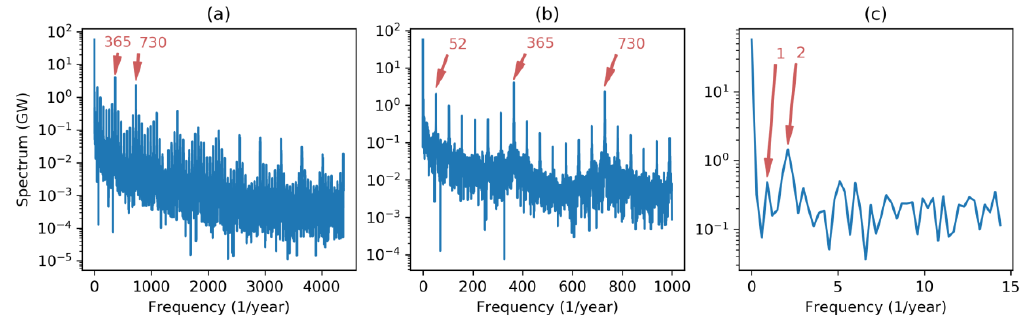
Figure 2. Electricity demand Fourier Spectrum at different frequency scales: ( a ) Full spectrum; ( b ) spectrum discarding higher frequencies; ( c ) low frequency spectrum.